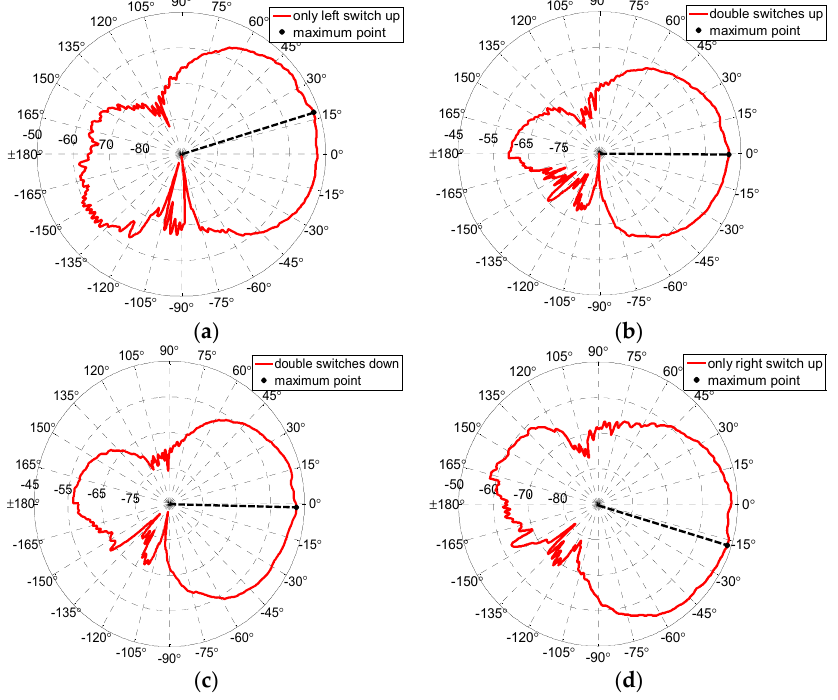
Figure 9. Measurement patterns of reconfigurable antenna for four modes. ( a ) Mode 1; ( b ) Mode 2; ( c ) Mode 3; ( d ) Mode 4.